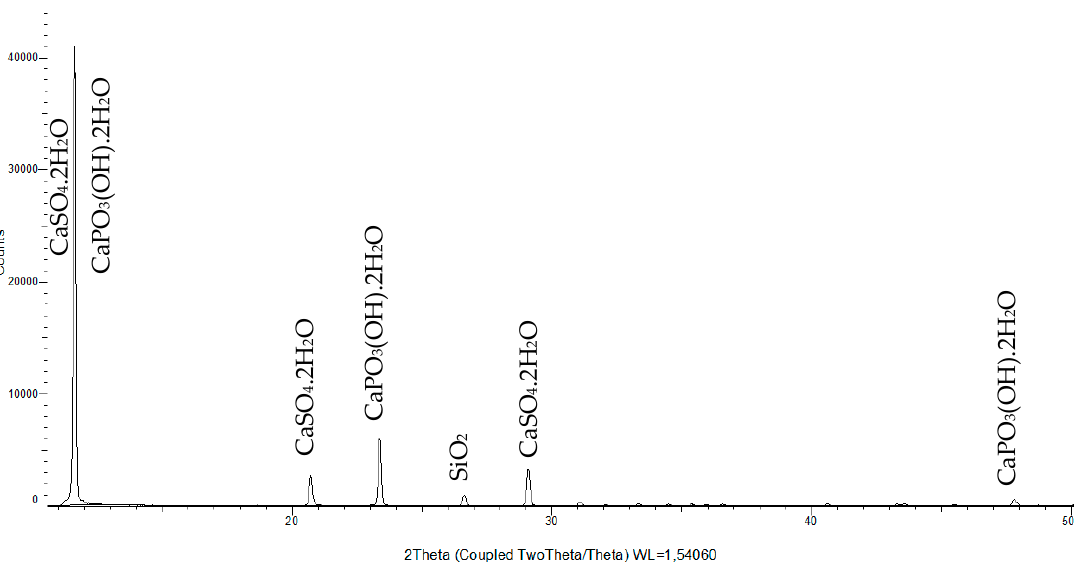
Figure 4. The X-ray diffraction pattern of phosphogypsum (terrace I).